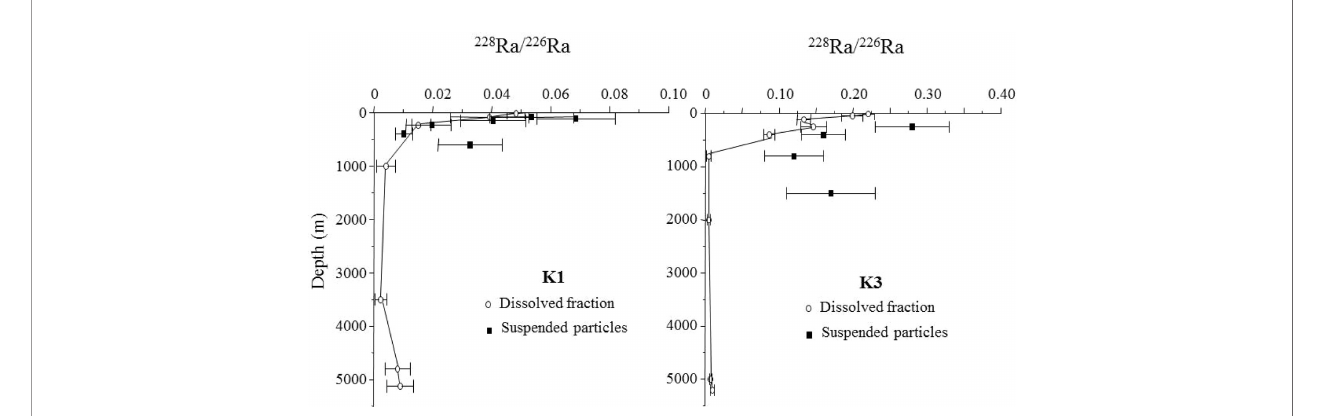
FIGURE 8 | Comparison of the 228 Ra/ 226 Ra ratios determined in the dissolved phases and suspended particles at stations K1 and